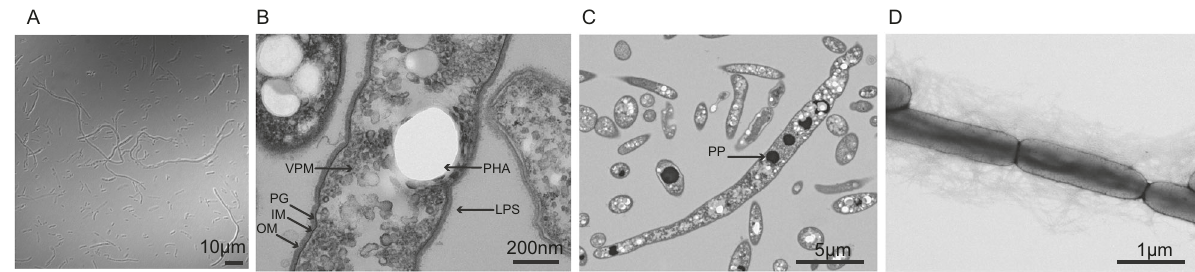
Fig. 5 Phase-contrast and transmission electron micrographs of strain WC8-2. A Phase-contrast micrograph, scale bar; 10 μ m, B and C Ultrathin section images of the cells showing the cell structure (scale bars; 200 nm for B , 5 μ m for C ). D Negative stain micrographs (scale bar; 1 μ m). The arrows indicate the cell structures: IM Inner membrane, LPS Lipopolysaccharide, MV Membrane vesicle, OM Outer membrane, PG Peptidoglycan, PP polyphosphate granules, PHA Polyhydroxyalkanoates, UG Unidenti fi ed granules, VPM Vesicular photosynthetic